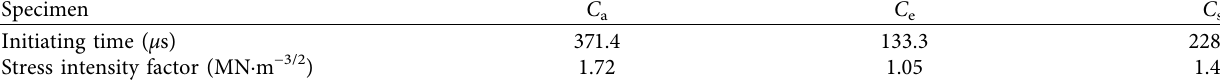
Table 2: The initiating time and corresponding stress intensity factor at the upper edge of the circular defect. Specimen